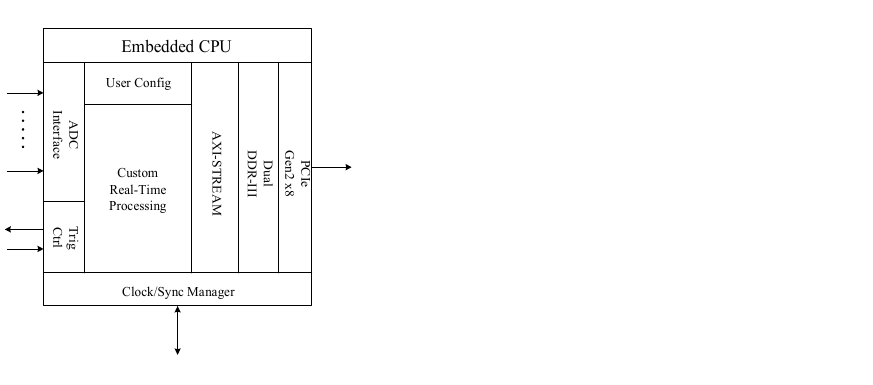
FPGA Figure 6. The internal logic interface diagram of FPGA. The user module has the function of logic redevelopment and provides the basic code of register reading and writing. The trigger control module is used to realize various trig- ger modes in the system and package and transmit collected data to the DDR module through the AXI-stream bus. The PCI-E module is mainly used to realize DMA data trans- mission between PC and FPGA. The SPI module is a SPI main controller, which can con- trol all kinds of chips of the analog front-end and relays. The DDR module calls the kernel of Xilinx to drive two sets of DDR3 on the board and combines these two sets of DDR3 interface to virtual two sets of FIFO interface. The SOC module mainly includes soft core processor, AXI bus controller, and register interface of trigger control module and SPI module. A lot of logic programming are implemented by Verilog HDL in FPGA—for example, the serial data to parallel data conversion, the PCIe transmission bus protocol, the data cache implementation, the logic function debugging, the performance testing, and so on. Figure 7 shows a schematic diagram of data acquisition and transmission using FPGA. When the FPGA receives the trigger signal, the acquisition and transmission system will continuously transmit data to the memory of the host computer while continuously cap- turing data. The processed data are transmitted to the Host computer through the PCIe connector using DMA transmission mechanism. This architecture can ensure the real-time of data acquisition and transmission, so as to ensure the real-time processing of the sys- tem.